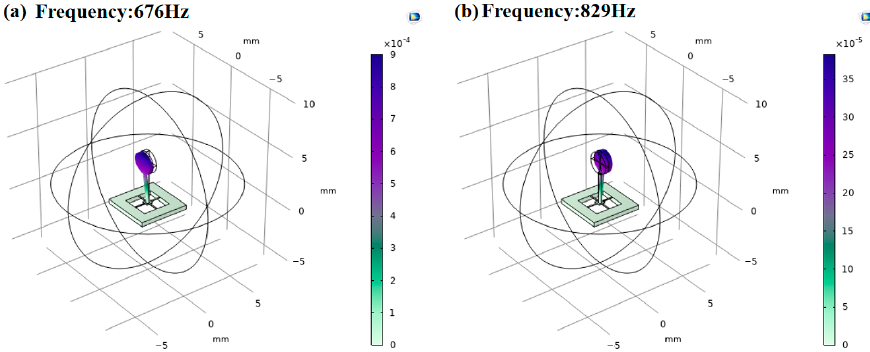
Figure 12. ( a ) Natural frequency in planar micro-structures. ( b ) Natural frequency in hollow concave micro-structures.